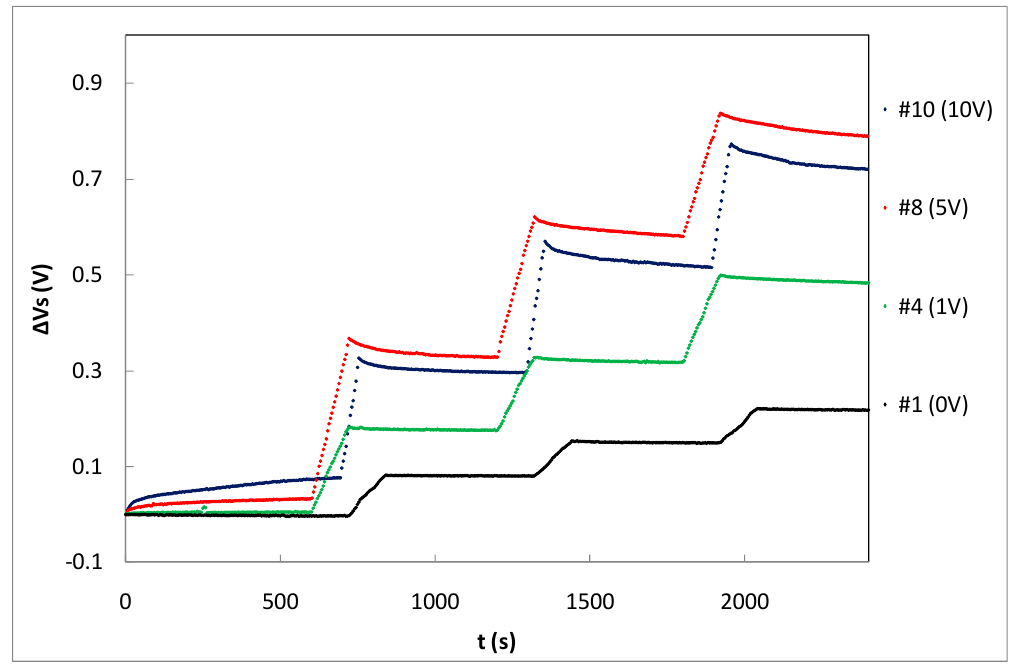
Figure 7. Source voltage increment during three irradiation shots of three samples biased at different gate voltages.